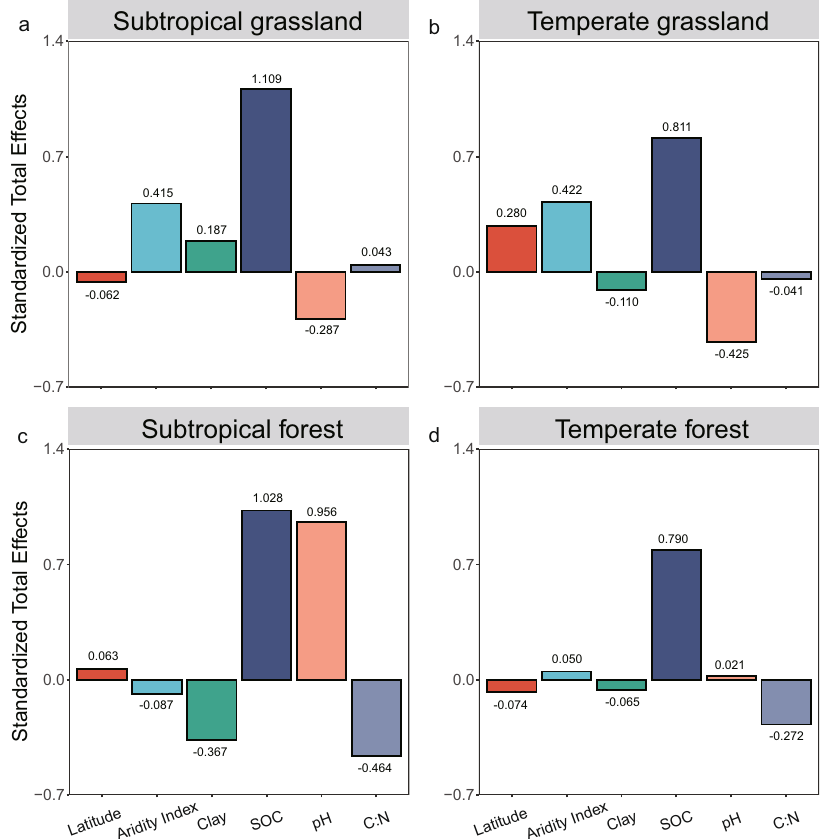
Fig. 7 Standard total effects of environmental variables on the absolute content of soil amino sugars. Standard total effects (direct and indirect effects) in structural equation models of: a subtropical grassland, b temperate grassland, c subtropical forest, and d temperate